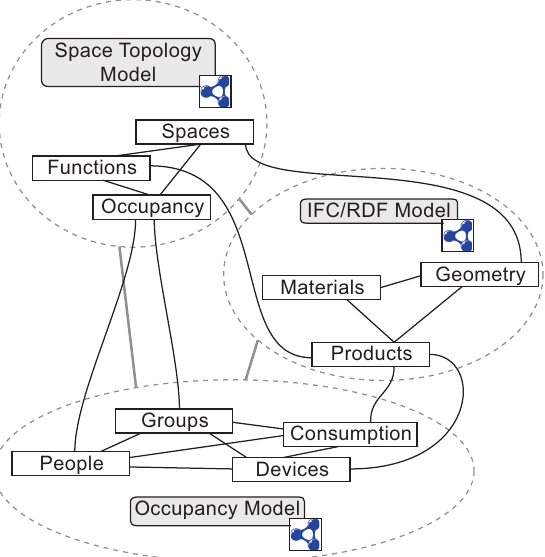
Figure 14. A combination of three partial models for a use case in performance evaluation in the design and construction